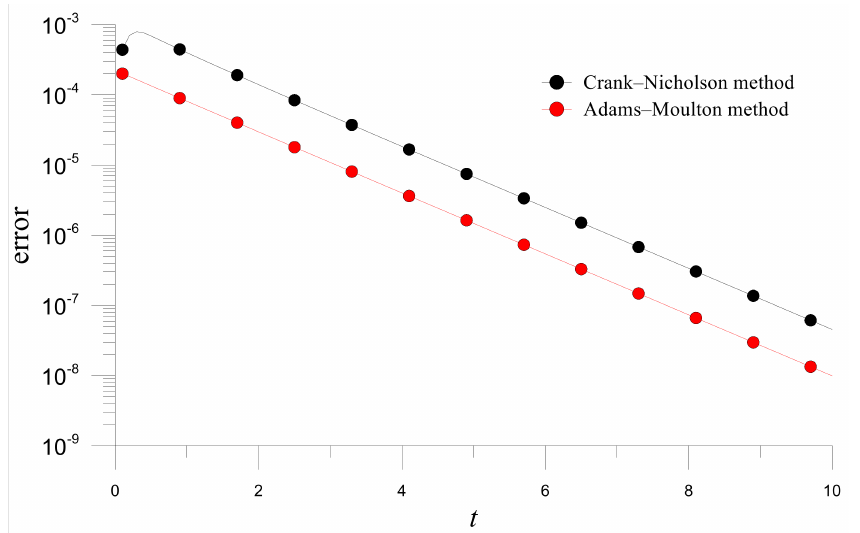
Figure 21. Errors of numerical solutions obtained by the Crank-Nicholson and Adams-Moulton methods for Example 5 ( ∆ t = 0.01, θ = 1 and N = 480